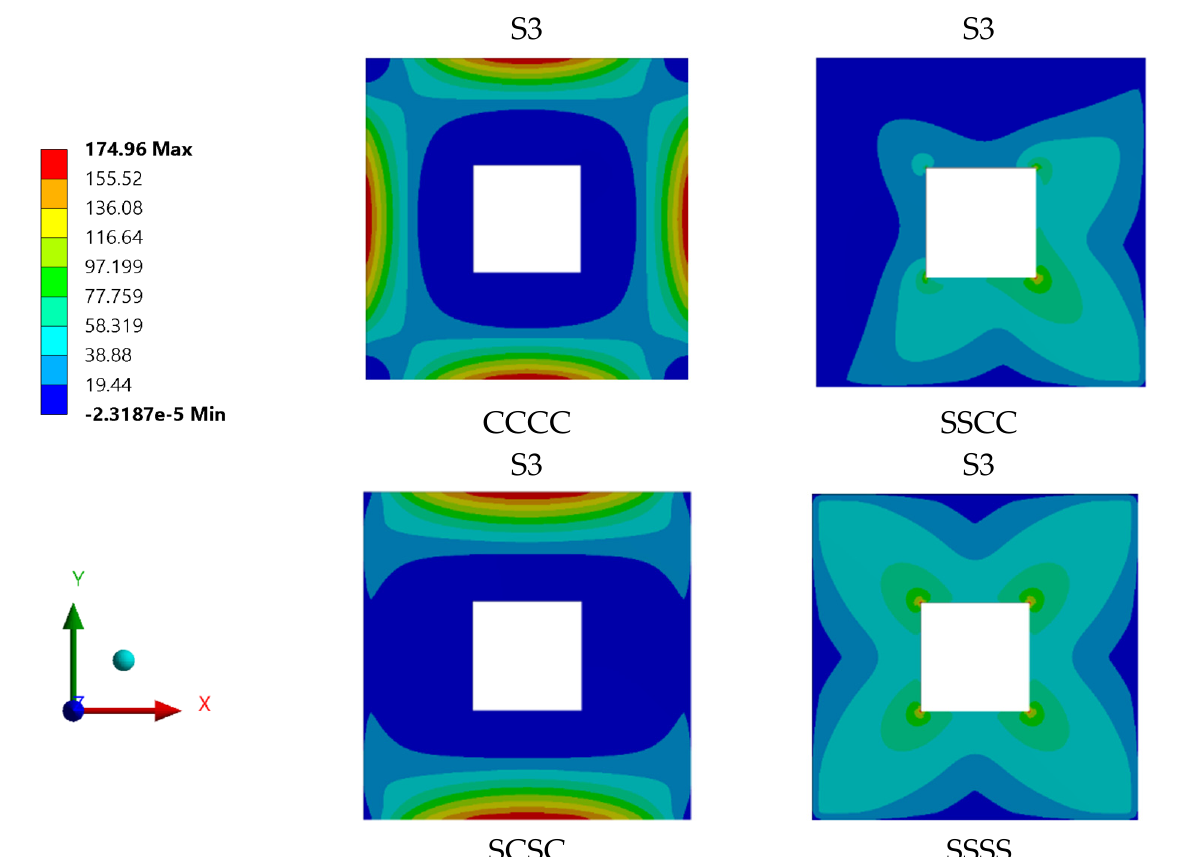
Figure 26. Stress distribution for individual plate specimens with different boundary conditions.